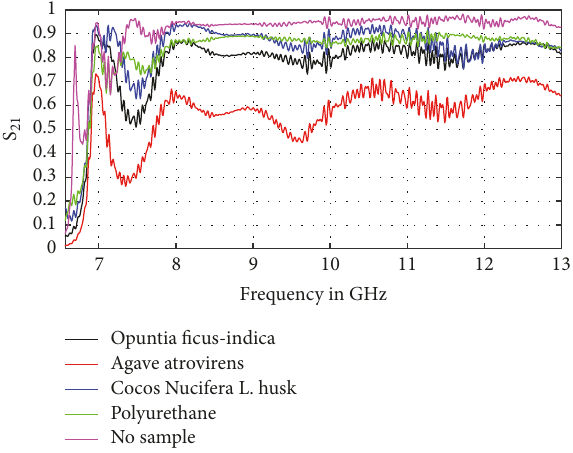
Figure 3: S 21 for the waveguide considering samples of organic materials, polyurethane, and no